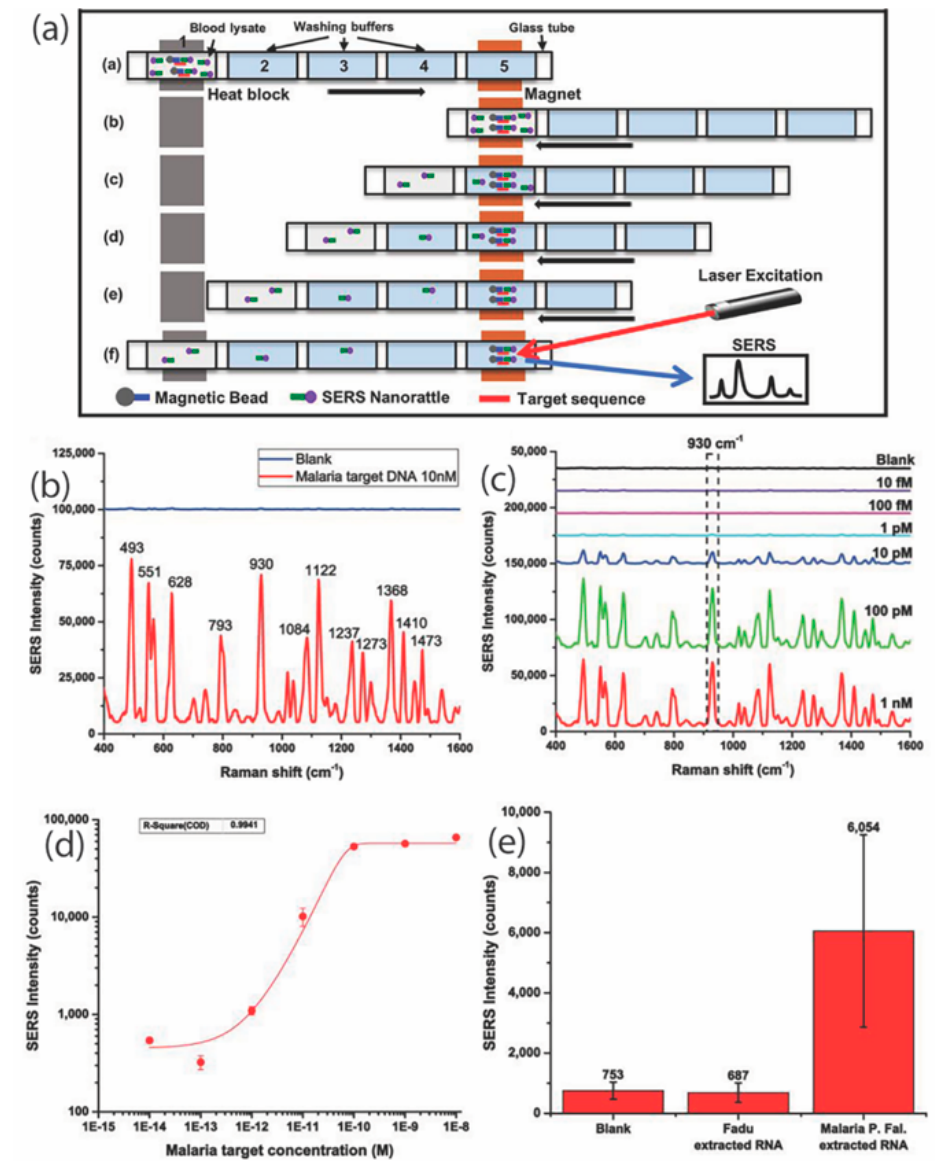
Figure 4. ( a ) Direct detection of plasmodium falciparum , malaria parasite, using an unamplified DNA and RNA biomarker. RNA biomarker sequence hybridized to the capture probe sequence on a magnetic bead and the reporter probe sequence on an ultra-bright SERS nanorattle with in a lab-in-a-stick device detection scheme. ( b ) SERS spectra displaying malaria synthetic DNA versus blank and ( c ) Malaria synthetic DNA with a concentration range of 10 fM to 1 nM. ( d ) Quantification of target DNA using the SERS intensity at the reporter signature peak at 930 cm − 1 , ( e ). Malaria P. falciparum 18s rRNA detection in blood lysate. Reproduced with permission from Reference [96] Scientific Reports (2018).